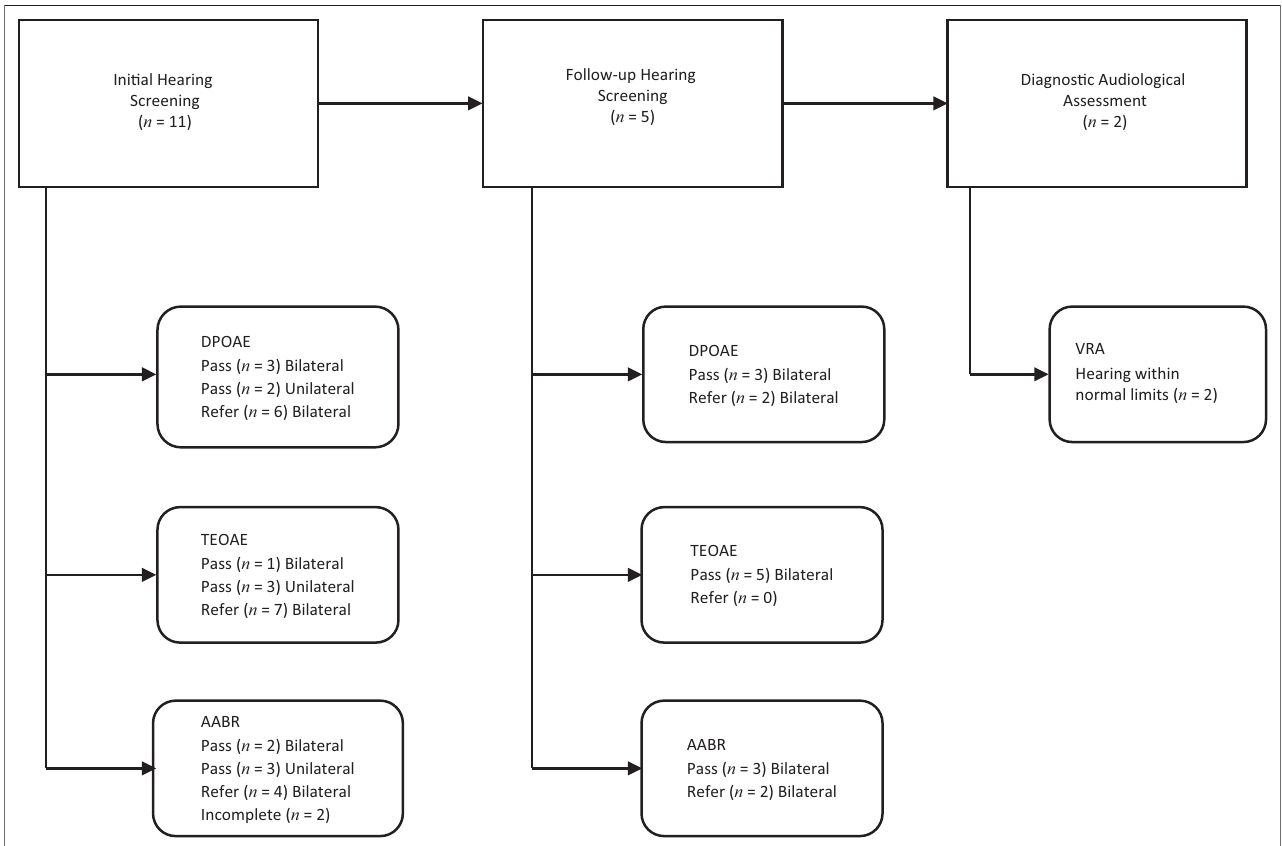
FIGURE 1: Outcomes of hearing screening protocol employed during data collection.